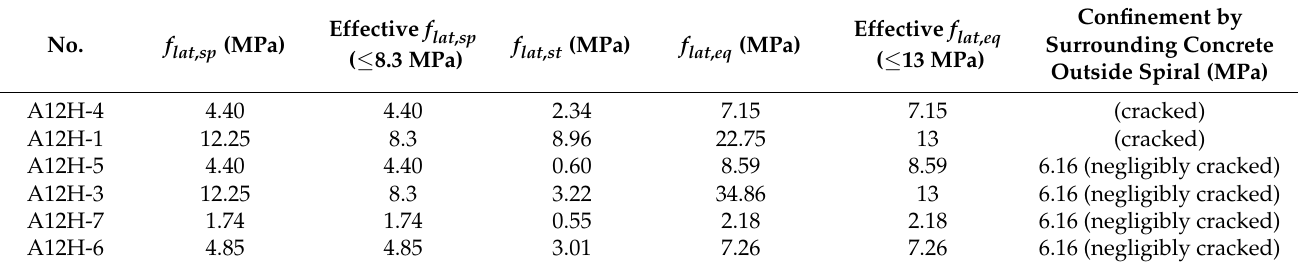
Table 3. Lateral confinement of group 2